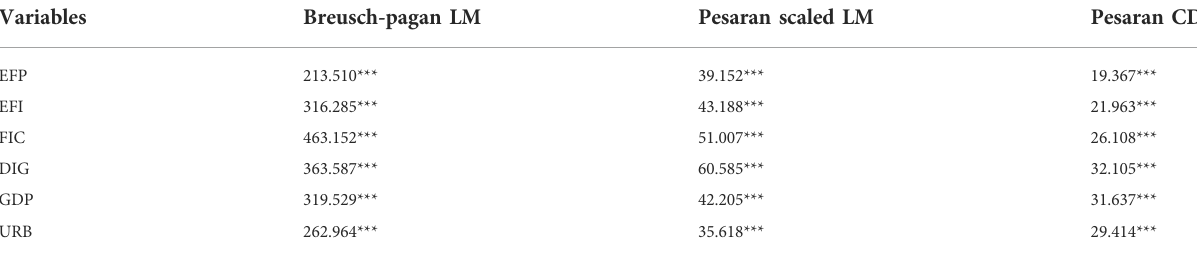
TABLE 2 Cross-sectional dependence fi